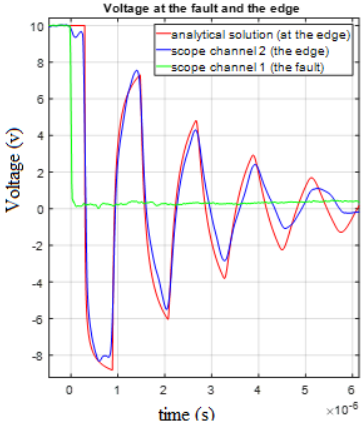
Figure 29. Comparison of the experimental results and theoretical predictions of Equation (105) for the measured voltage.